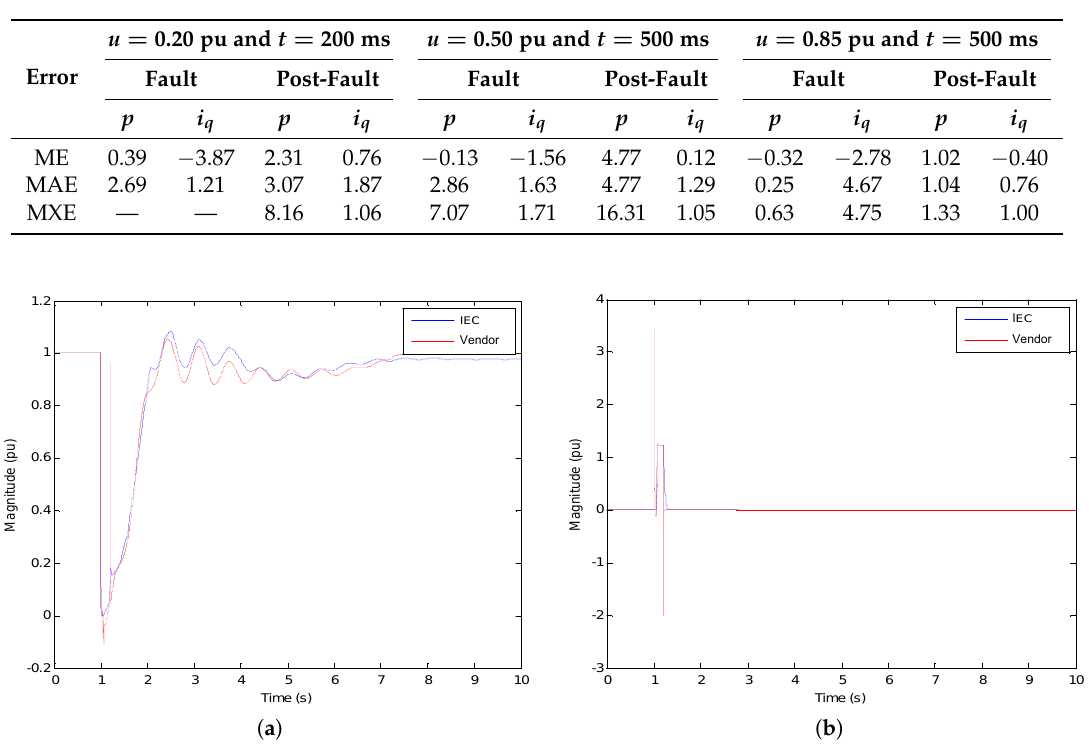
Figure 7. Type IIIB results. Simulation scenario: p = 1.0 pu, u = 0.20 pu, t = 200 ms, w s = 1.1. ( a ) Active power, p ; and ( b ) reactive current, i q